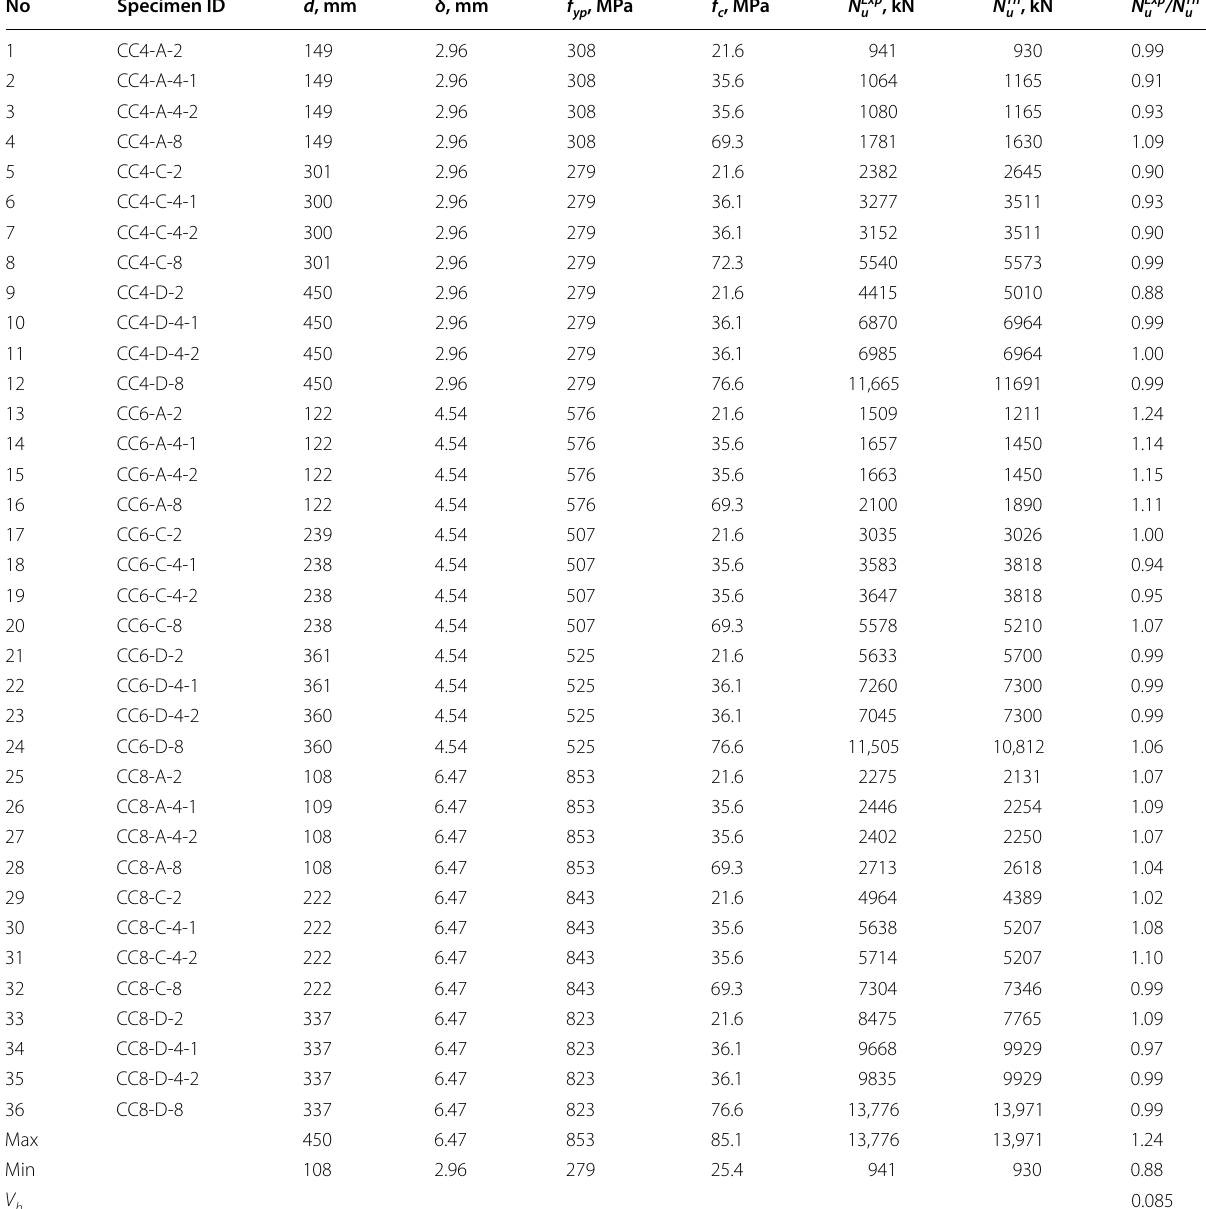
Table 2 Results of comparison of theoretical and empirical loads to